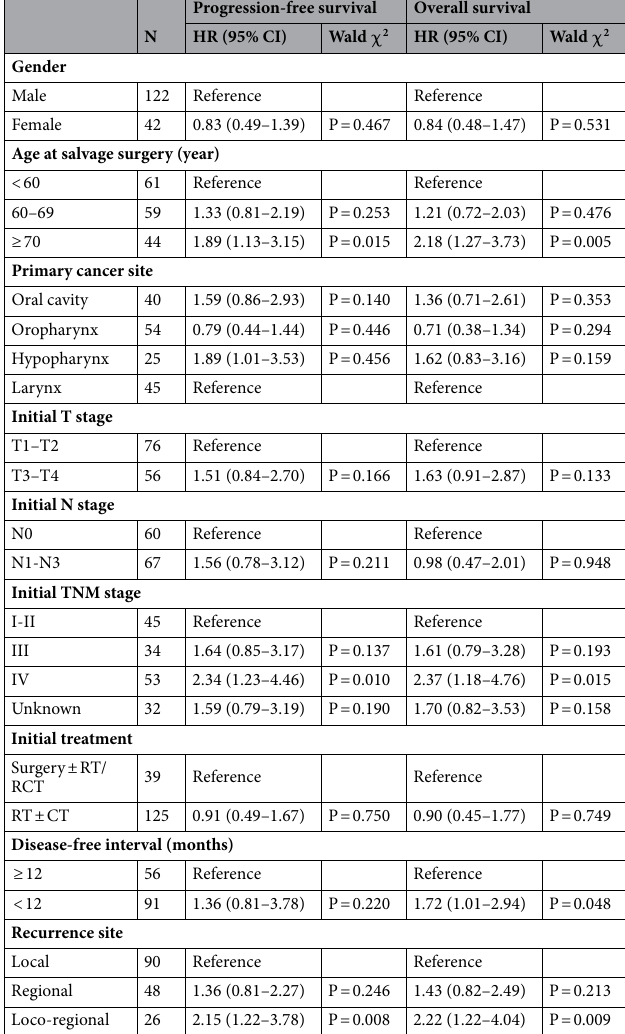
Table 2. Multivariable hazard ratio (HR) a and corresponding 95% confidence intervals (CI) of PFS event and death for socio-demographic characteristics and pre-operative clinical features. RT radiotherapy, CT chemotherapy, CRT chemo-radiotherapy. a Estimated through Cox proportional hazard model, adjusting for gender, age, primary cancer site, initial TNM stage, disease-free interval and recurrence